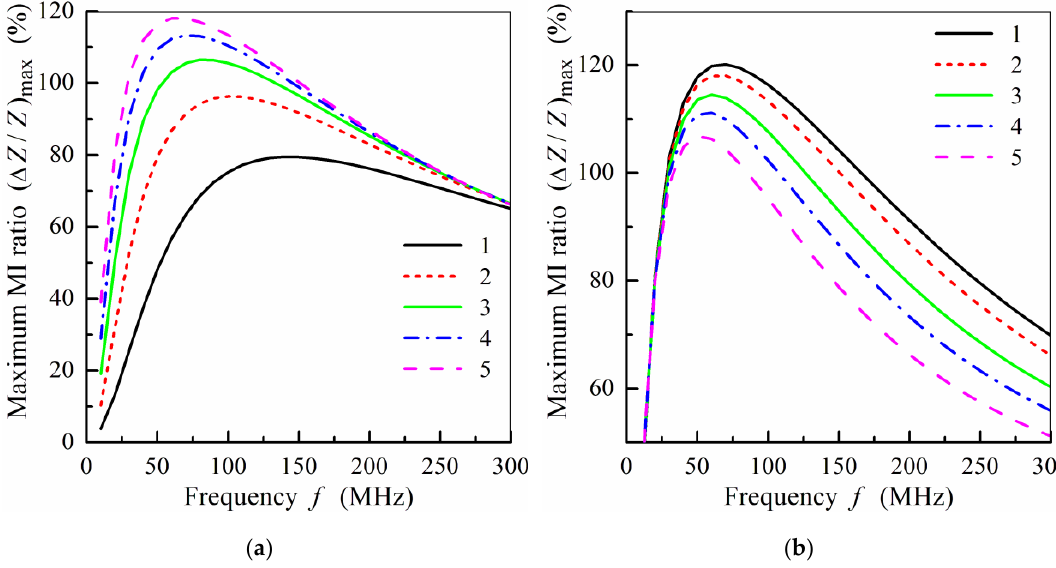
Figure 4. ( a ) Frequency dependence of the maximum MI ratio, ( ∆ Z / Z ) max , at di ff erent values of the central layer thickness, 2 d 0 : curve 1, 2 d 0 = 100 nm; curve 2, 2 d 0 = 200 nm; curve 3, 2 d 0 = 300 nm; curve 4, 2 d 0 = 400 nm; curve 5, 2 d 0 = 500 nm. ( b ) Frequency dependence of the maximum MI ratio, ( ∆ Z / Z ) max , at di ff erent values of the thickness, d 1 , of spacers: curve 1, d 1 = 2 nm; curve 2, d 1 = 3 nm; curve 3, d 1 = 5 nm; curve 4, d 1 = 7 nm; curve 5, d 1 = 10 nm. Other parameters used for calculations are the same as in Figure 2.